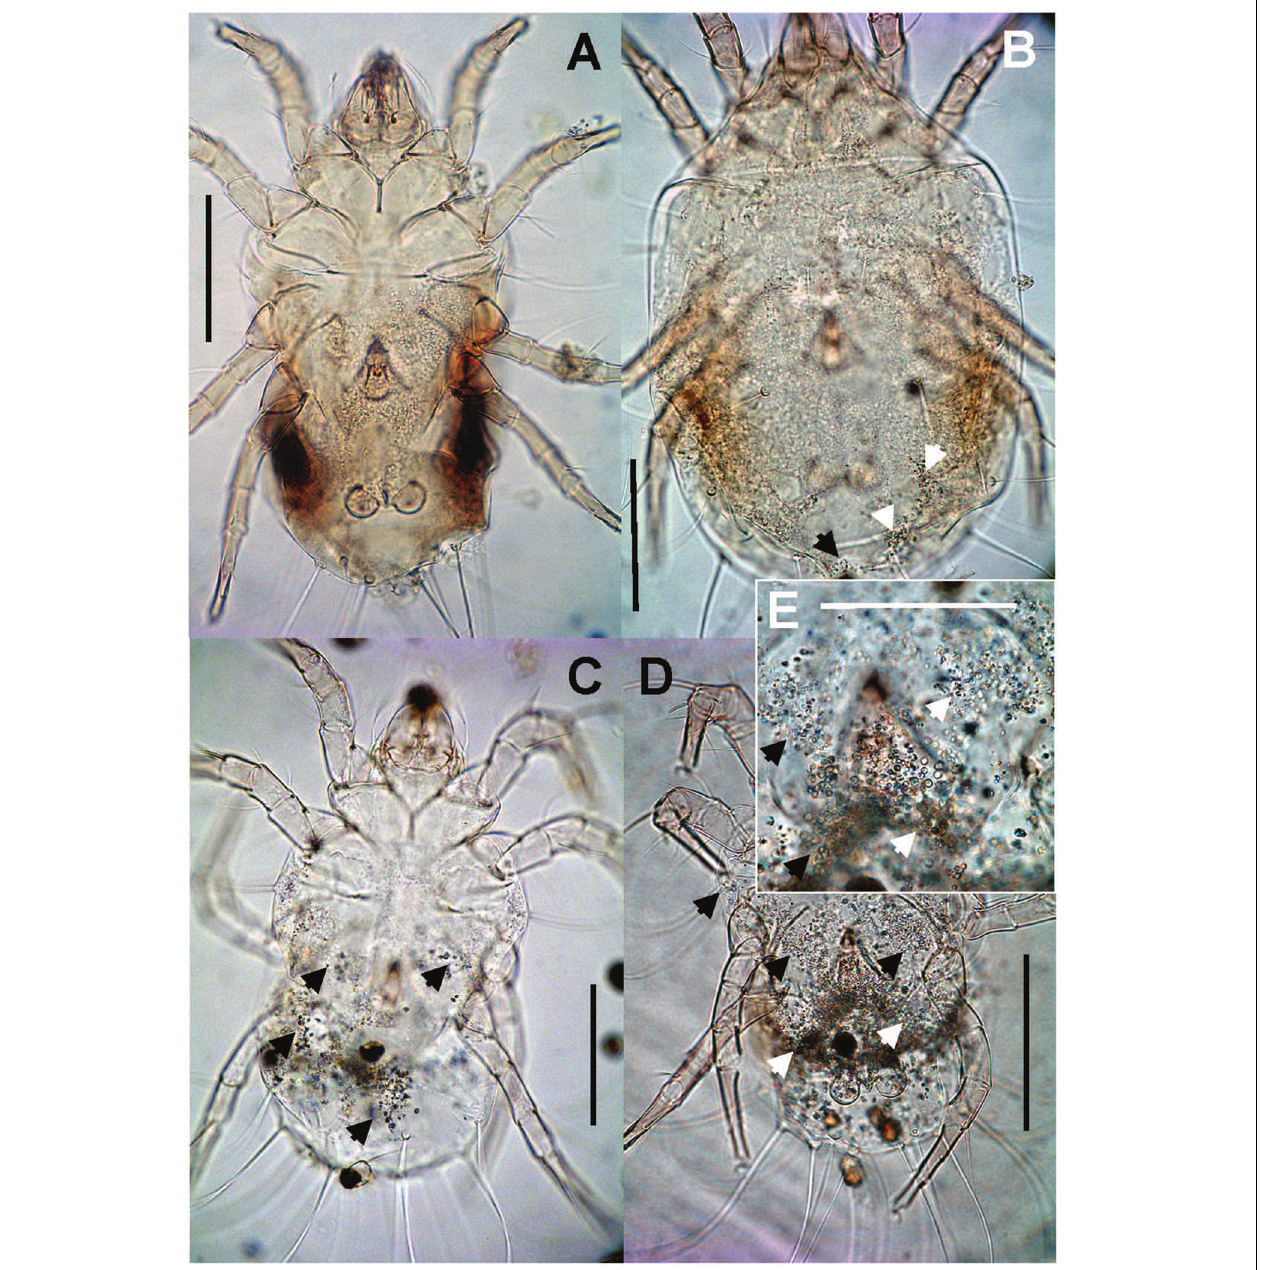
FIGURE 9 | Guanine deposits in T. putrescentiae (mite are mounted on permanent microscopic slides): (A) no guanine granules; (B) a low number, the granules fill less than 25% of the hysterosoma; (C) intermediate, the granules fill 25–50% of the hysterosoma; (D) massive, the granules fill more than 50% of the hysterosoma, (E) detail of the previous image. Scales: (A–D ) 100 µ m, (E) 25 µ